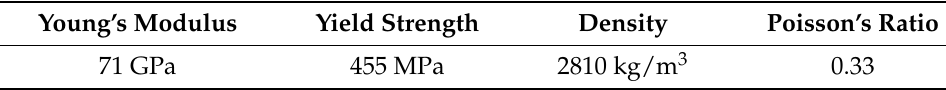
Table 2. The material of the hybrid mechanism of Al7075.